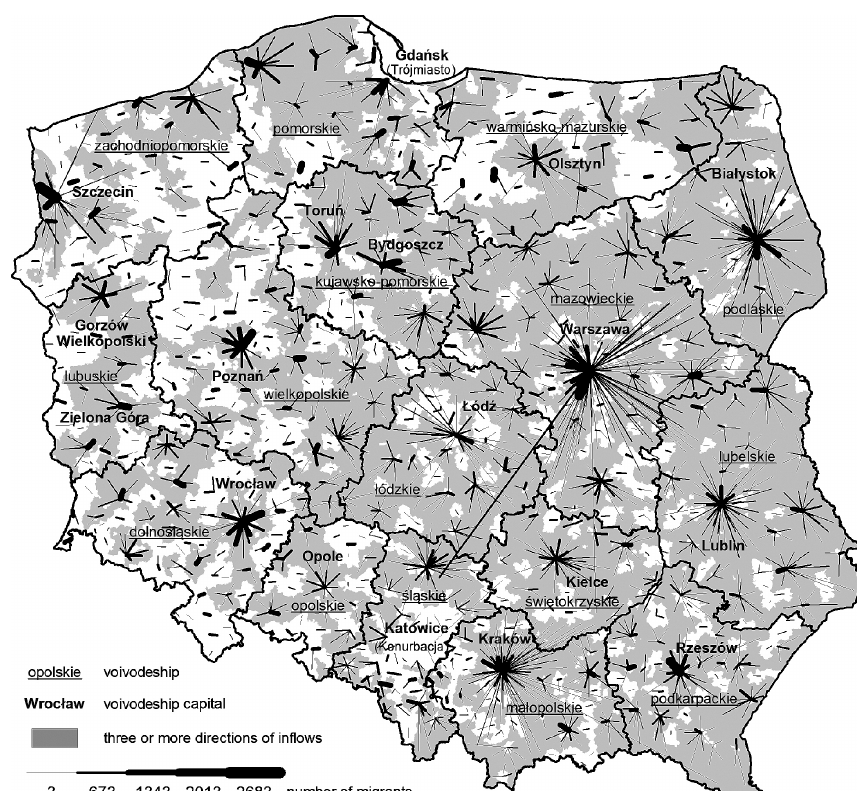
Fig. 1. Migratory catchment areas – rural areas as migration origins (linear